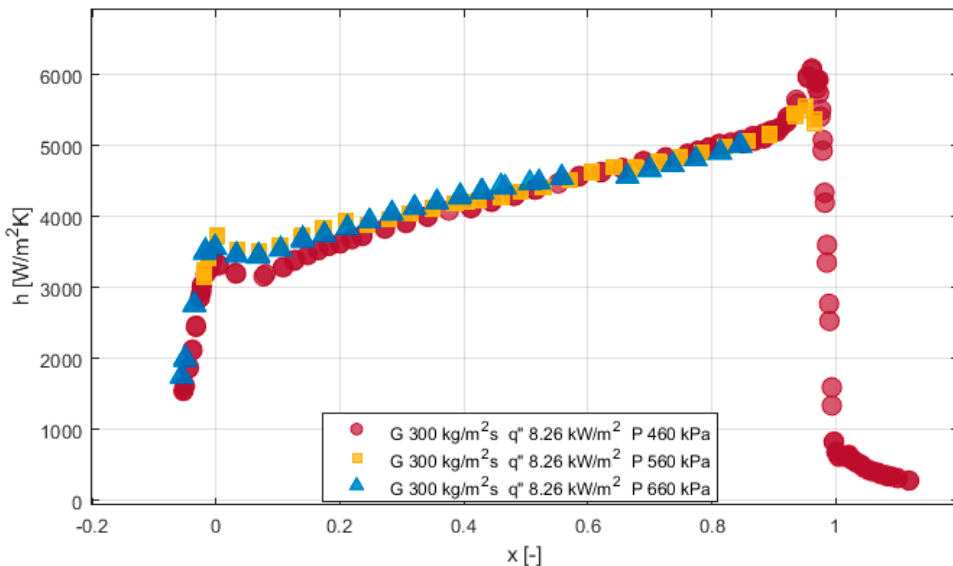
Figure 7. Effect of saturation pressure on heat transfer coefficient for mass flux of 300 kg/m 2 s and heat flux of 8.26 kW/m 2.